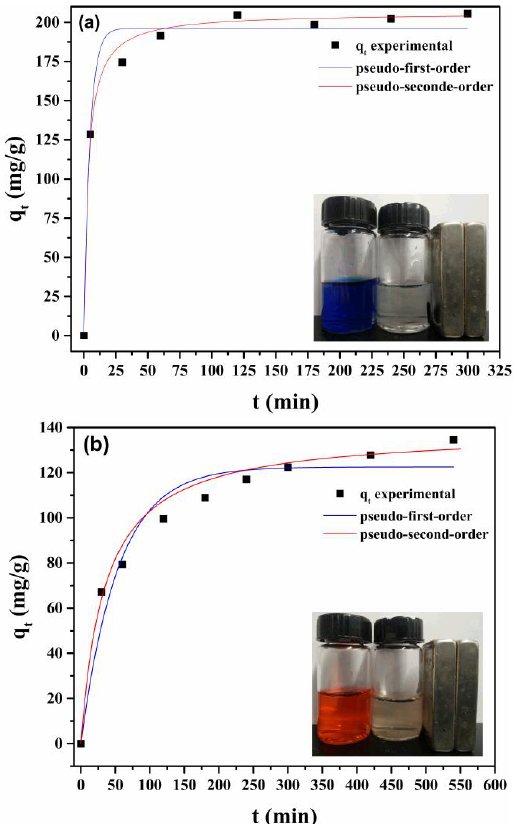
Figure 9. Adsorption kinetic profiles of: ( a ) MB onto LMNPs; and ( b ) AS-GR onto LAMNPs, at the initial concentration of 100 mg/g (for both MB and AS-GR) in 80 mL. The insets are the original dye solution and the separation of the dye-loaded NPs with an external magnetic field.